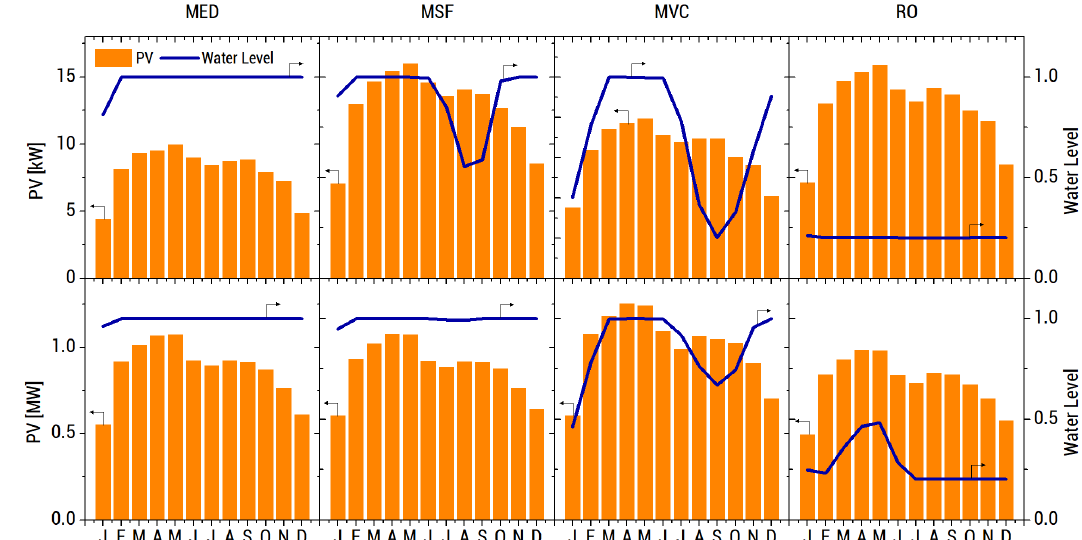
Figure 12. Hourly desalination energy consumption and water storage fraction on Camasusu Island (top) and Lubang Island (bottom). Power consumption is uneven in the RO system on Camasusu Island.